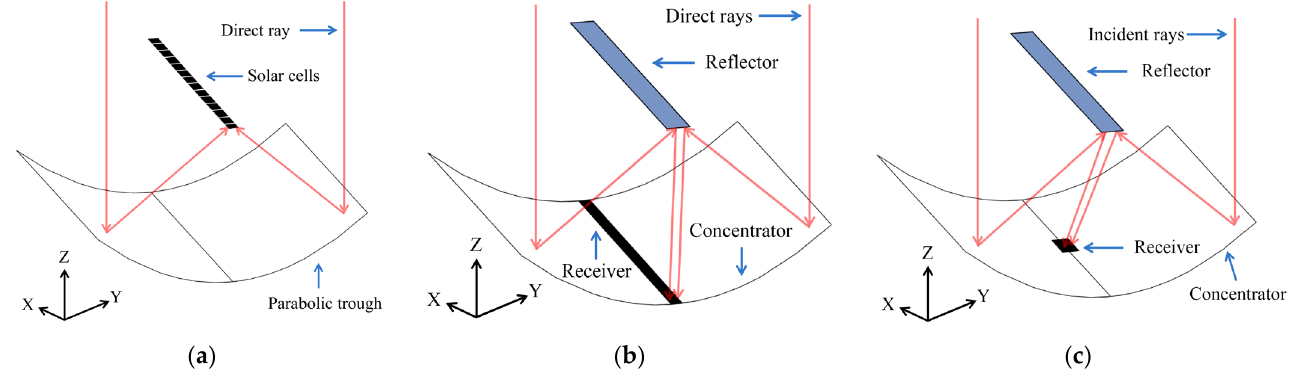
Figure 1. ( a ) Trough with linear focus, ( b ) trough with linear focus with two stage concentration, and ( c ) trough with focus on the center with two stage concentration.